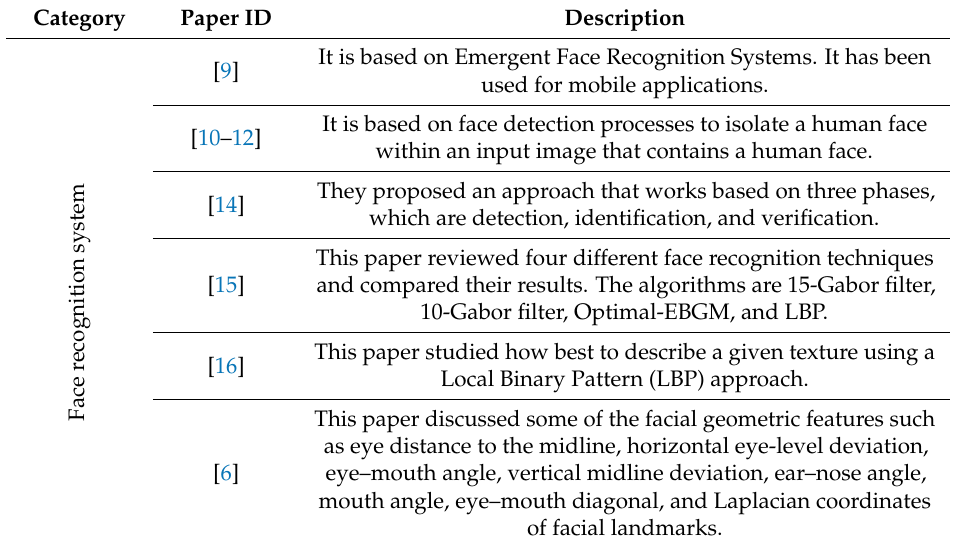
Table 2. Summary of the related